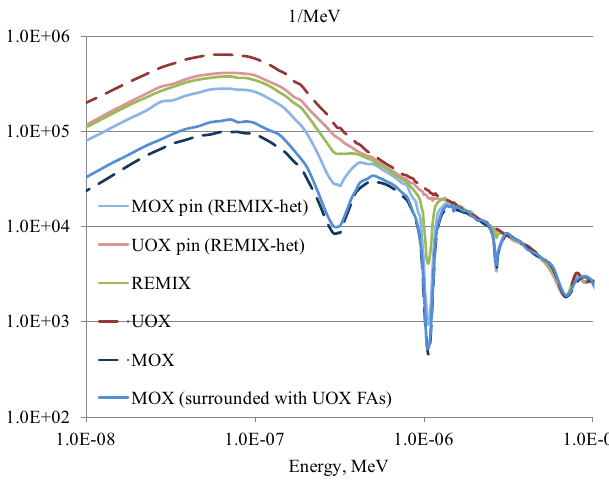
Fig. 7. Spectrum effects for different fuel compositions.